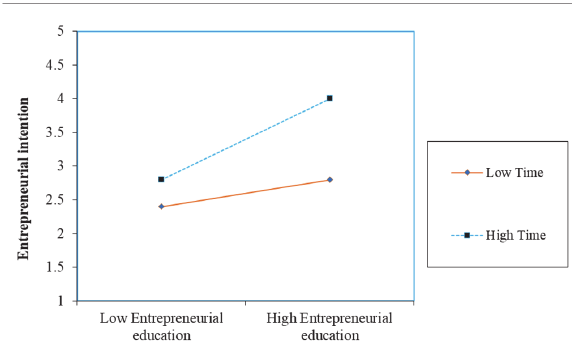
Fig. 7. The regulatory role of